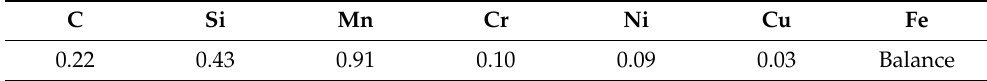
Table 1. Nominal chemical composition (wt.%) of the low carbon cast steel